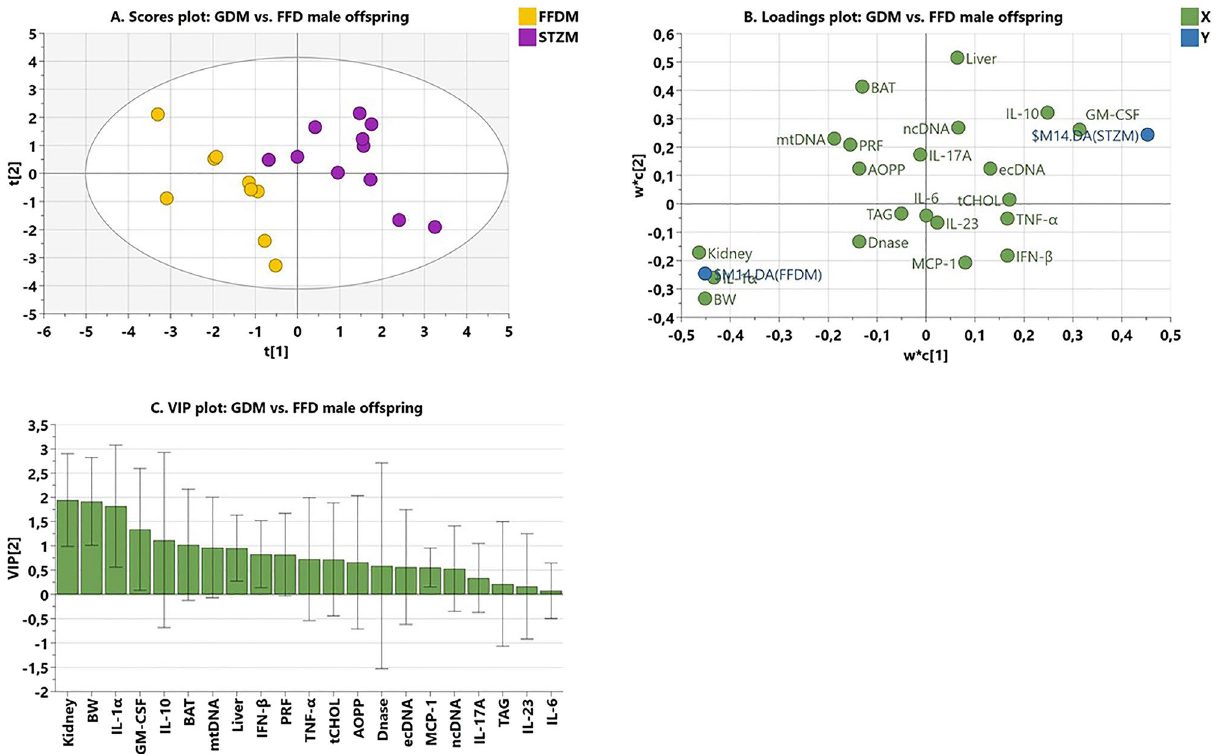
Figure 6. ( A ) The scatter plot of the scores visualizes in the horizontal direction the separation between the male offspring of dams consuming the fast-food diet (FFD, yellow circles) and those from dams consuming an FFD presenting with gestational diabetes mellitus (STZ, violet circles); while the vertical direction shows the within-group variability; ( B ) loading scatter plot displays the relationship between independent variables (green circles) and dummy variables representing the groups of FFD and STZ (GDM) male offspring (blue circles). Independent variables situated in the vicinity of dummy variables have the highest discriminatory power among the groups; those positioned near the FFD dummy variable are higher in FFD offspring; while those nearby the STZ (GDM) dummy variable were higher in GDM than in FFD offspring; ( C ) the VIP plot summarizes the importance of the variables for between-group separation sorted from high to low. Variables with VIP ≥ 1.00 are considered significant. BW, body weight; kidney, liver, BAT, PRF relative weight of kidneys, liver, brown adipose tissue, and perirenal fat, respectively ; Chol, TAG liver content of total cholesterol and triacylglycerols, respectively; ecDNA the concentration of extracellular DNA; ncDNA, mtDNA genomic equivalents of nuclear and mitochondrial DNA in plasma, respectively; IL-1α interleukine-1 alpha; IL-6 interleukine-6; IL-17A interleukine-17A; IL-23 interleukine-23; IL-10 interleukine-10; TNF-α tumor necrosis factor-alpha;